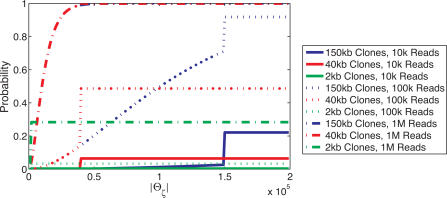
Probability of localizing a fusion point to an interval of a given length.A fusion point ζ is localized to length s if the corresponding breakpoint point region Θζ has length s or less. When s exceeds the clone length L, only a single clone is required to achieve this localization and consequently the probability of localization is the probability that at least one clone contains the fusion point. In the case of 1 M paired reads the 40 kb and 150 kb curves are nearly indistinguishable. Note that each curve is obtained using a fixed clone length, and that the use of a distribution of clone lengths would create a less abrupt transition.